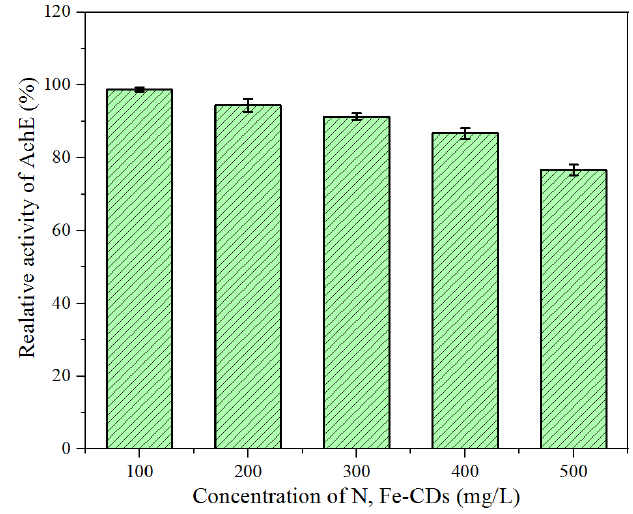
Figure 8. Effect of N,Fe-CDs on the activity of AchE.